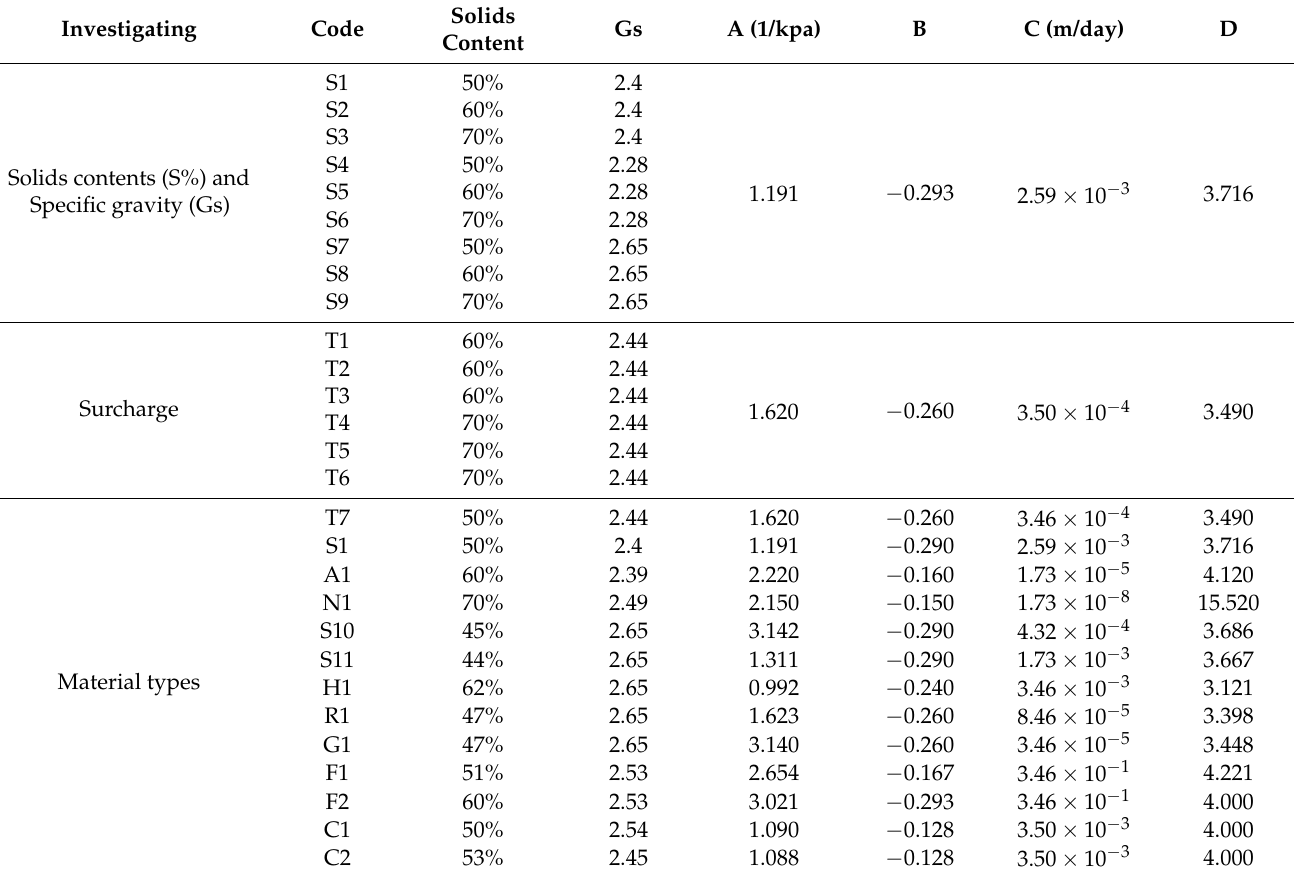
Table 2. Scenarios considered in the 1D settlement sensitivity